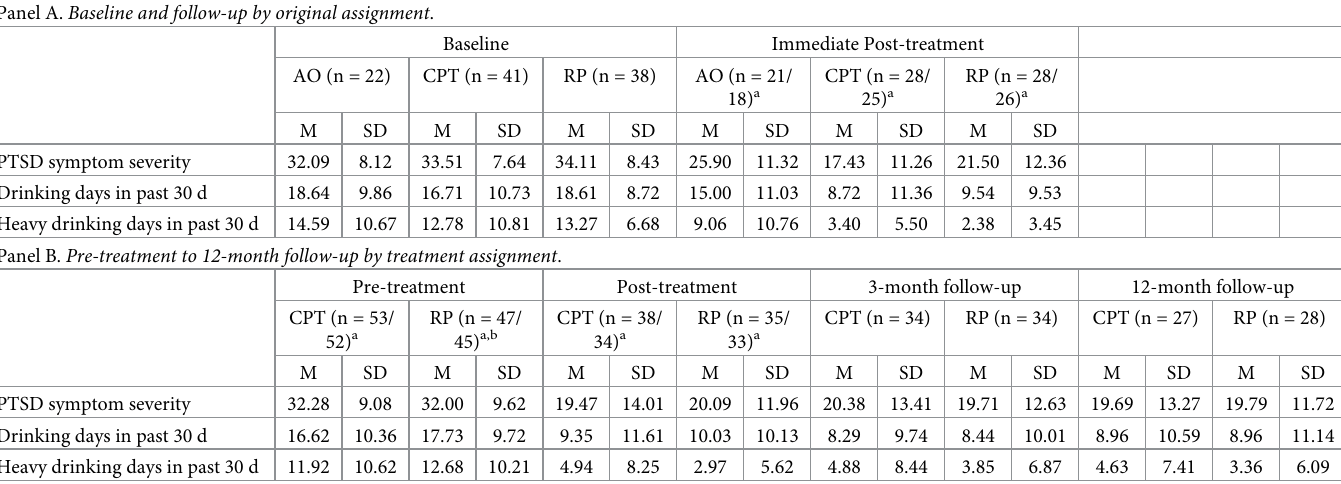
Table 1. Descriptive statistics for main outcomes stratified by condition. Panel A. Baseline and follow-up by original assignment